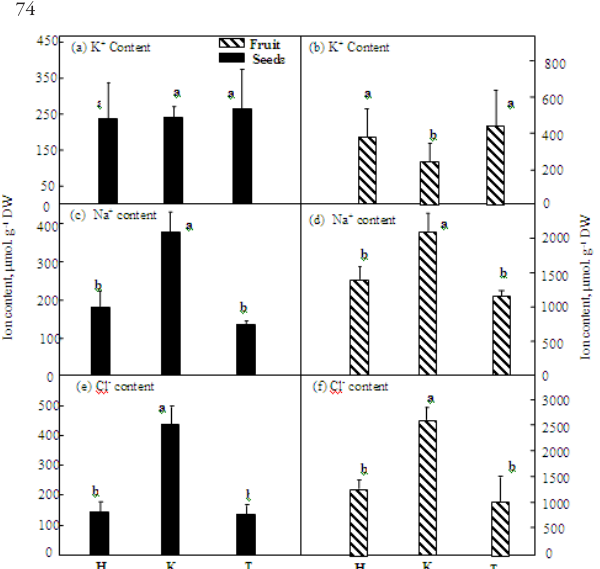
London.Fig. 2. Variability of Na + , K + , and Cl - content (µmol. g -1 DW) between provenience. H, K, and T stand for Haouaria, Kelibia, and Tabarka, respectively. Mean values that are marked with more letters are significtly different at